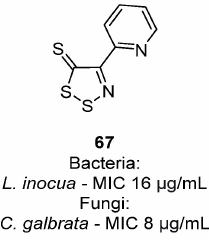
Figure 11. The 4-(pyridin-2-yl)-5 H -1,2,3-dithiazole-5-thione ( 67 ) was the only compound with potent antimicrobial activity from the C4 substituted analogue